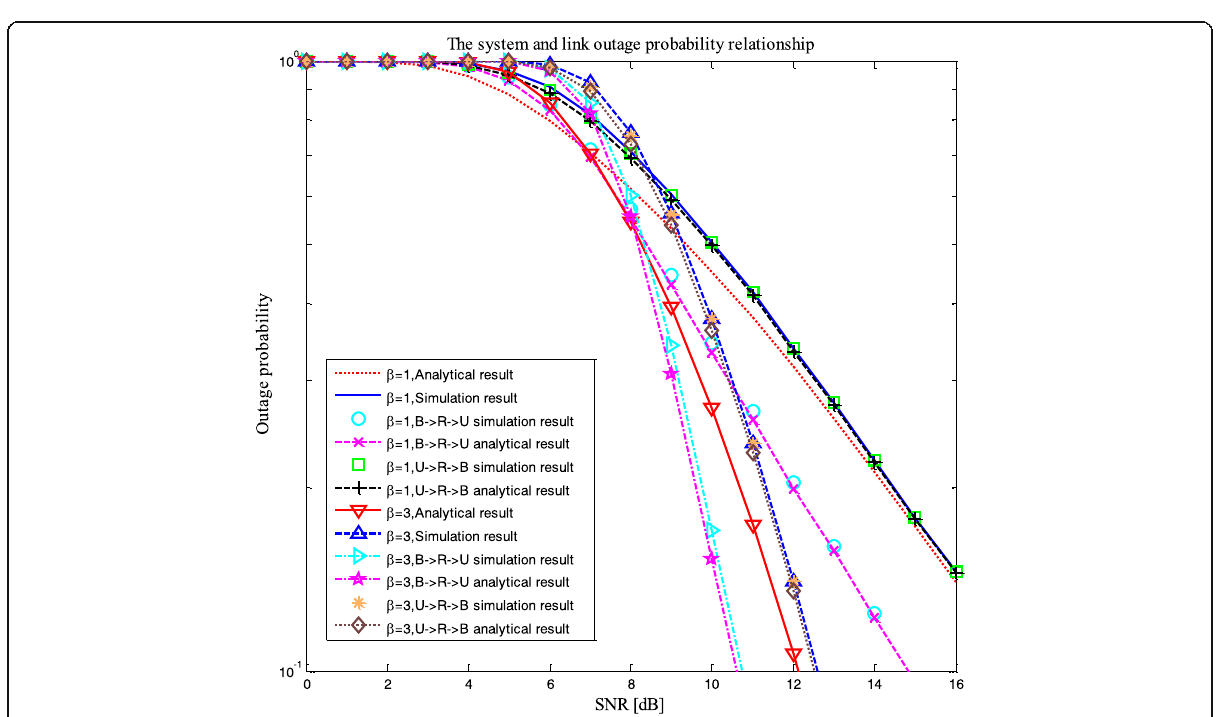
Fig. 4 The system and link outage probability